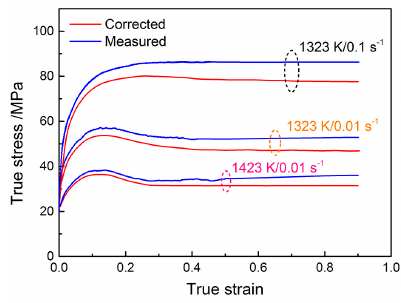
Figure 2. Comparisons between the measured flow curves and friction corrected curves.